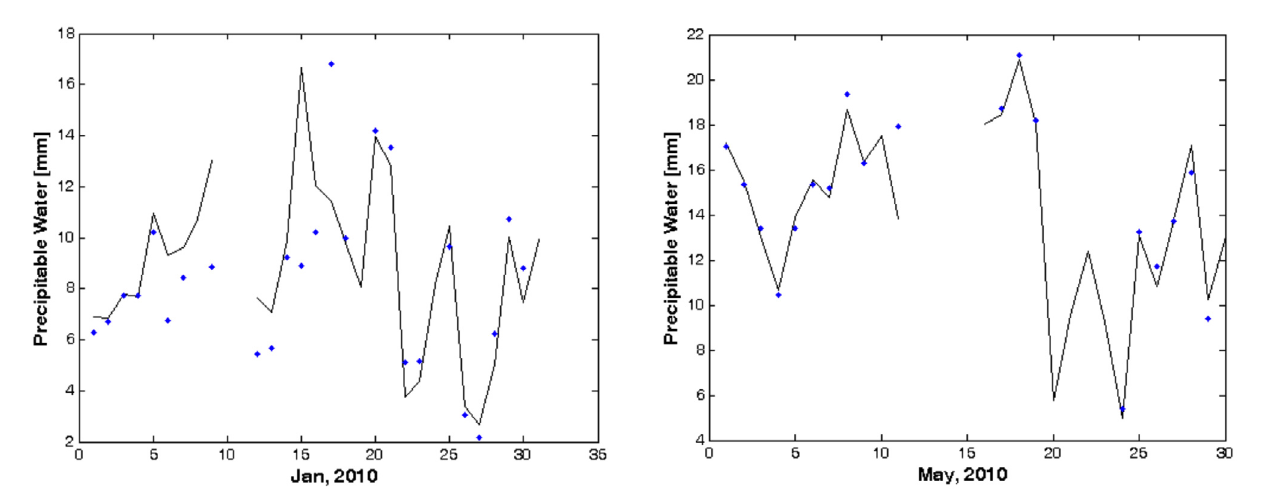
Figure 4. Time series of the estimated pecipitable water at station Tehran in January 2010.